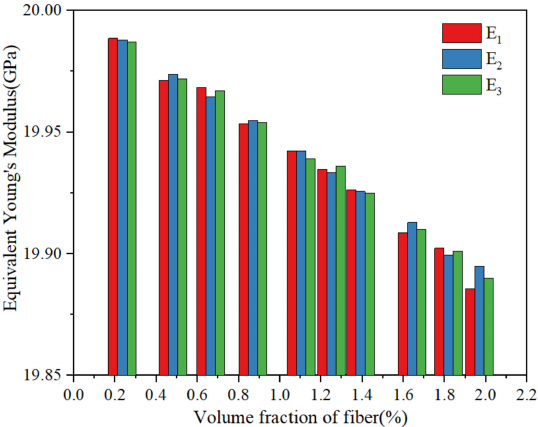
Figure 12. Variation trend in equivalent Young’s modulus.